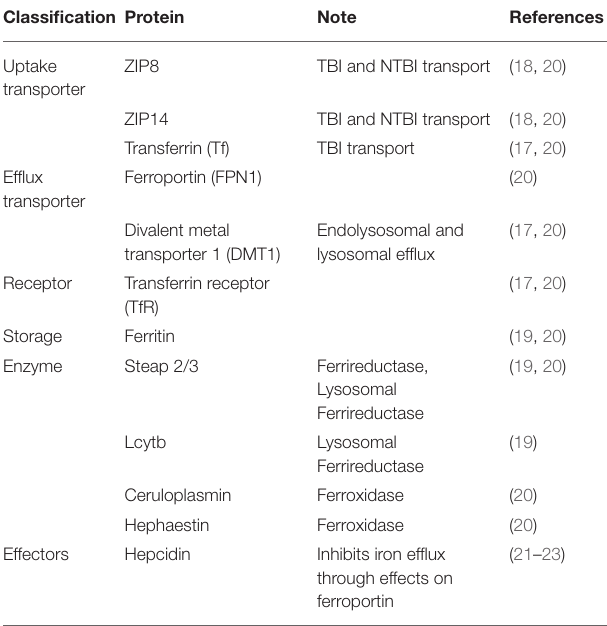
TABLE 1 | Iron metabolism proteins in BMVEC. Classification Protein